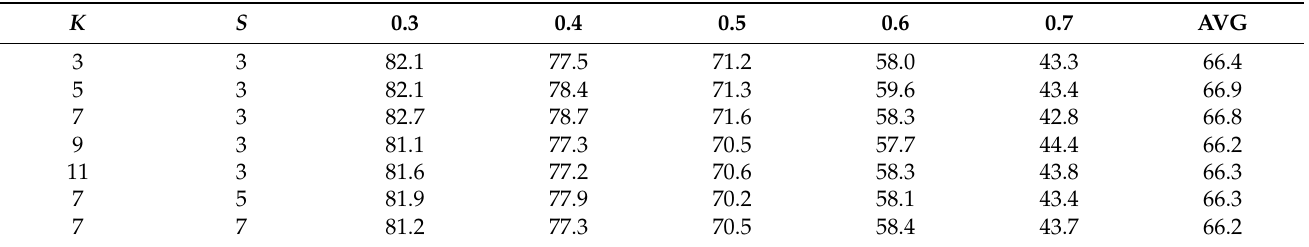
Table 4. Ablation Study (impact of TD module). Comparing the effects of convolution kernel size ( K ) and max pooling size ( S ) on THUMOS-14, measured by mAP@tIoU at different thresholds and the average mAP (mAP@avg) [0.3:0.1:0.7].